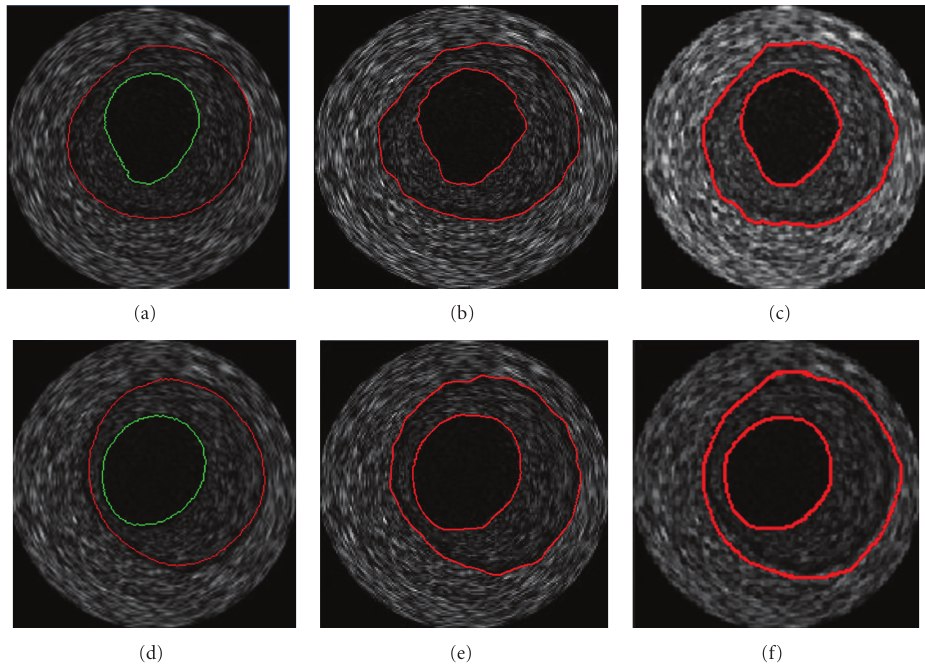
Figure 4: Two examples of simulated images segmentation results. ((a), (d)) Real boundaries (ground truth), ((b), (e)) traditional method, and ((c), (f)) the proposed